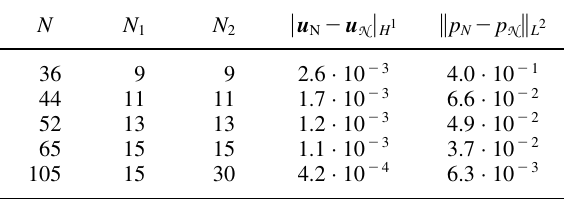
Table 3. The error in the reduced basis steady Stokes solution on a multiblock system corresponding to Figure 1. N (cid:1) N 1 (cid:4) 3 N 2 is the total number of degrees-of-freedom in the reduced basis spaces X 0 , X e , and M N . N 1 is the numberof basis geometriesused N N to generate the basis functions on the pipe block, N 2 is the number of basis functions used on the bifurcation